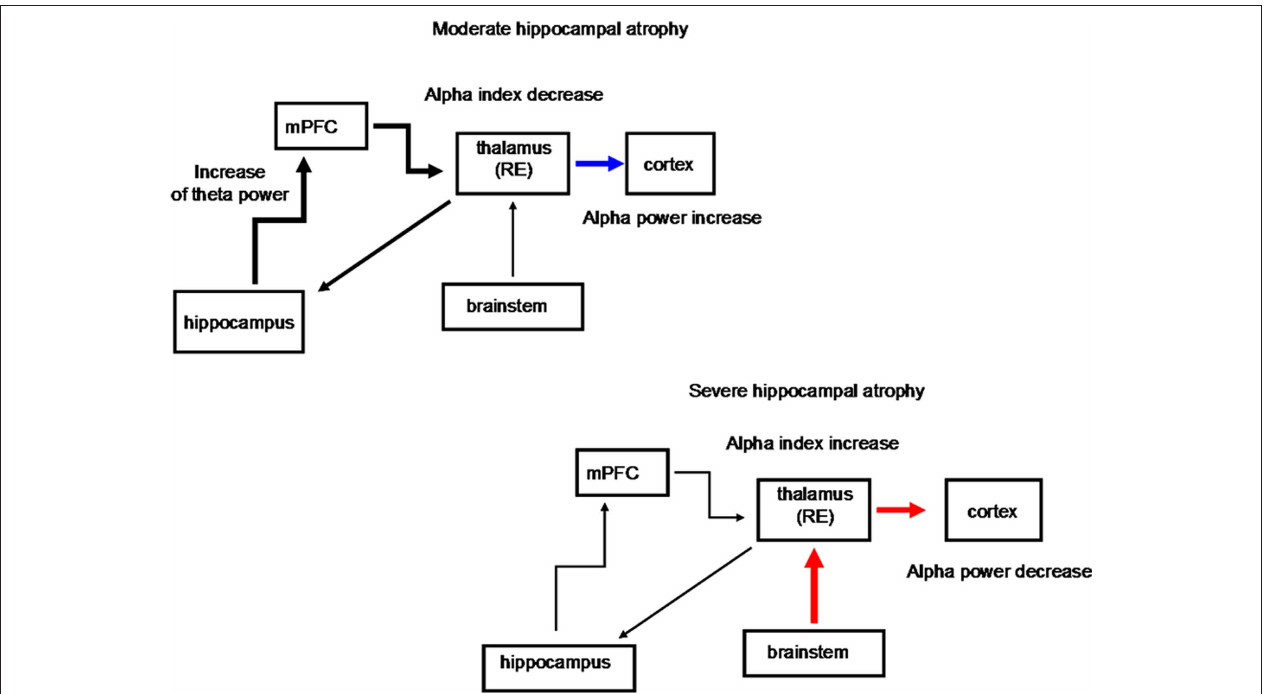
FiGurE 3 | Schematic diagrams of the possible structures involved in the thalamo-cortical arrhythmia in groups with moderate and severe hippocampal atrophy. The progressive hippocampal atrophy, as in the moderate hippocampal-atrophy group, triggers thalamo-cortical synchronization, with increase in the alpha power band. This is likely to happen because the return pathway from the cortex to the hippocampus is not direct, but it mainly relays to the midline and mediodorsal thalamic nuclei. The decrease in the values for the alpha frequency markers in the moderate hippocampal-atrophy group